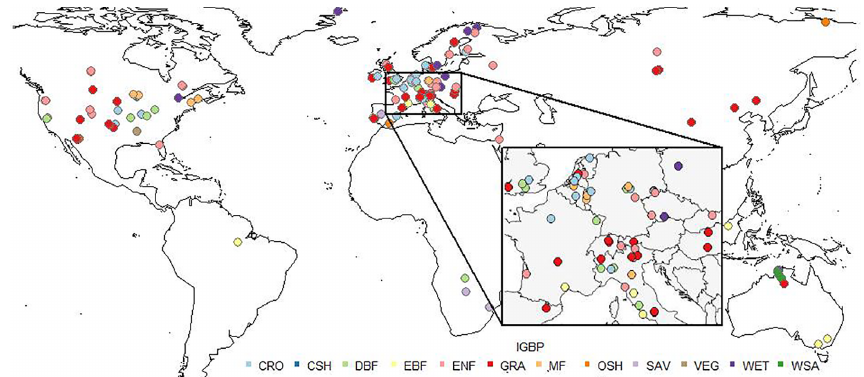
Figure 2. Location of the 159 flux tower sites involved in building DOLCE, classified by vegetation type given by IGBP: croplands (CRO), closed shrublands (CSH), deciduous broadleaf forest (DBF), evergreen broadleaf forest (EBF), evergreen needleleaf forest (ENF), grasslands (GRA), mixed forests (MF), open shrublands (OSH), savannas (SAV), cropland/natural vegetation mosaic (VEG), wetlands (WET), and woody savannas